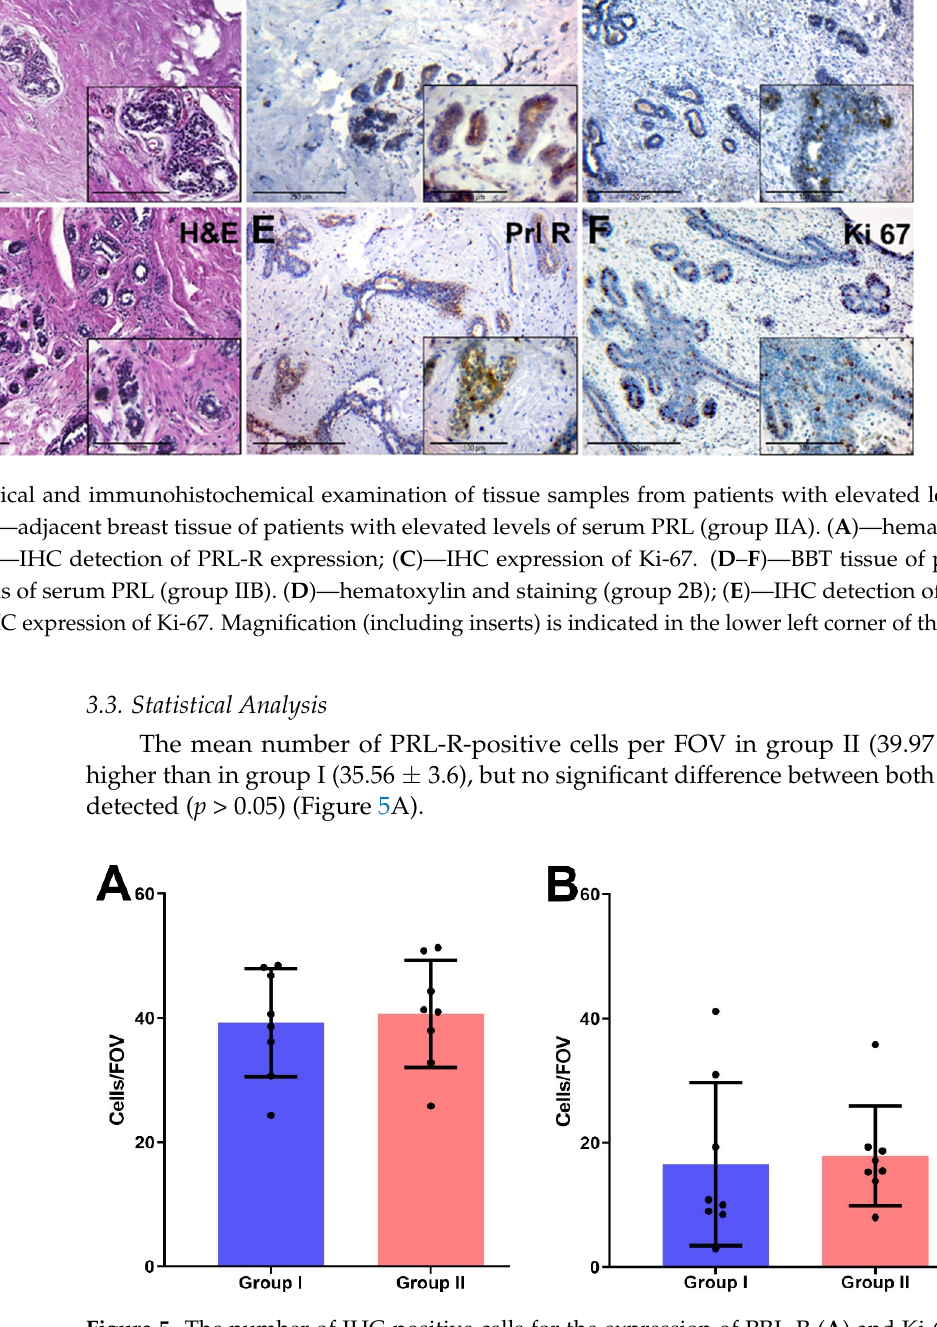
Figure 5. The number of IHC-positive cells for the expression of PRL-R ( A ) and Ki-67 ( B ) in BBT tissues of I and II groups per field of view.